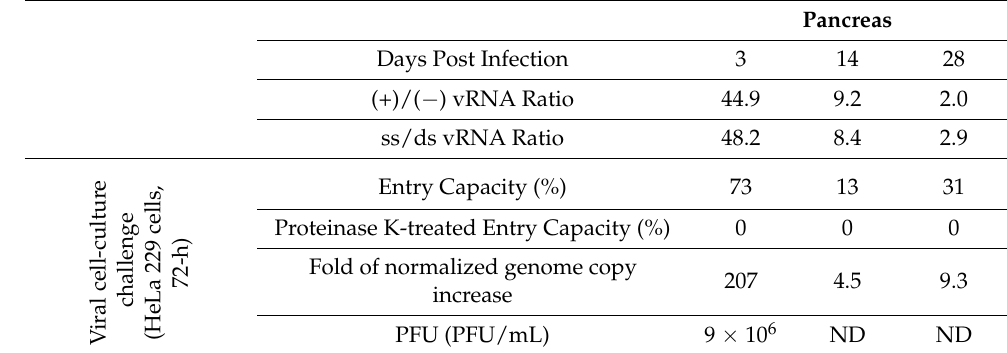
Table 1. Viral properties of CVB-RNA populations in the